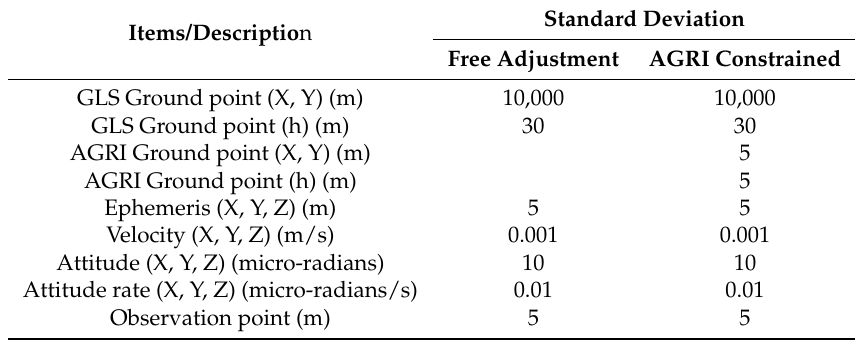
Table 2. Standard deviations used to determine the weights in the free adjustment and Australian Geographic Reference Image (AGRI)-constrained triangulation